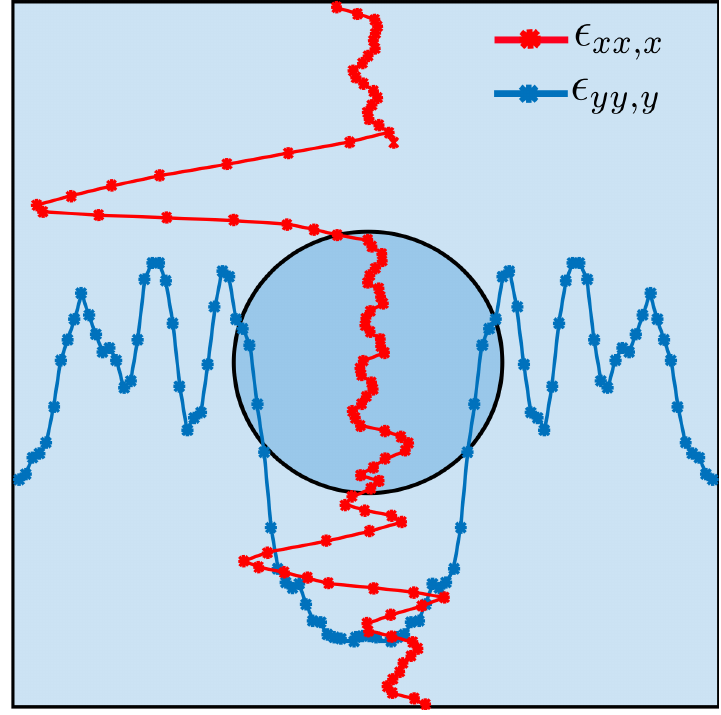
Figure 9. Calculation results of a square composition under compression: ( a ) strain profile in the y direction; ( b ) induced electric potential.